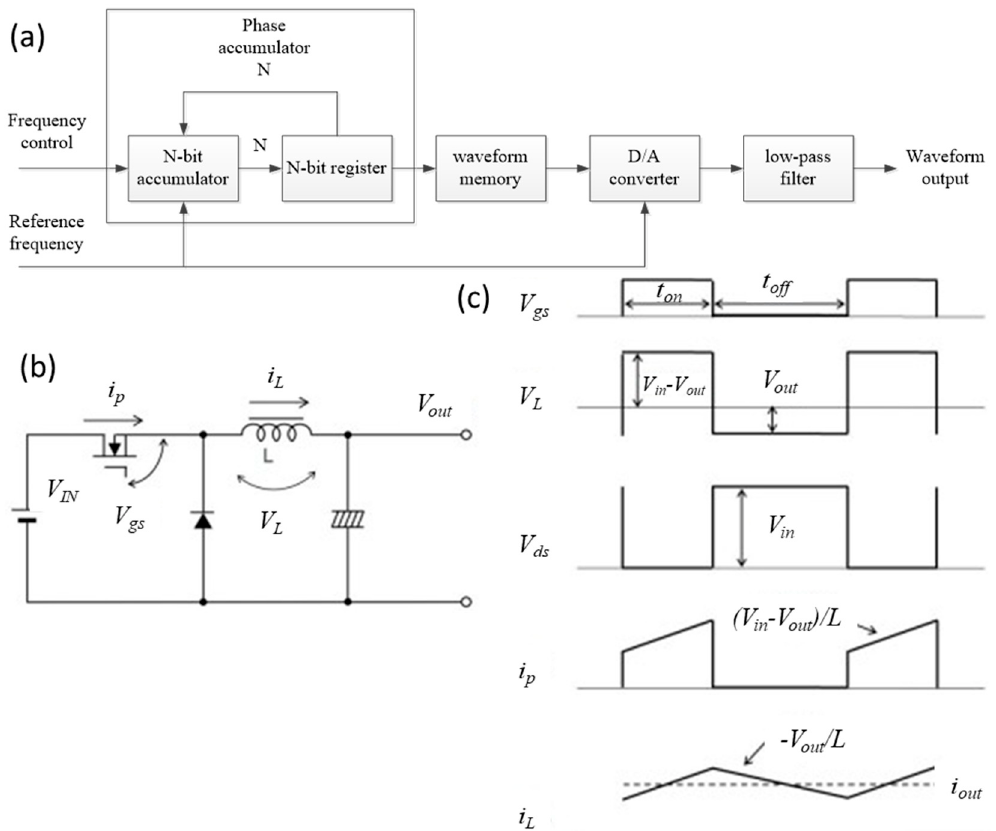
Figure 2. ( a ) Direct digital synthesis; ( b ) Buck converter; ( c ) Working sequence diagram of the buck converter.